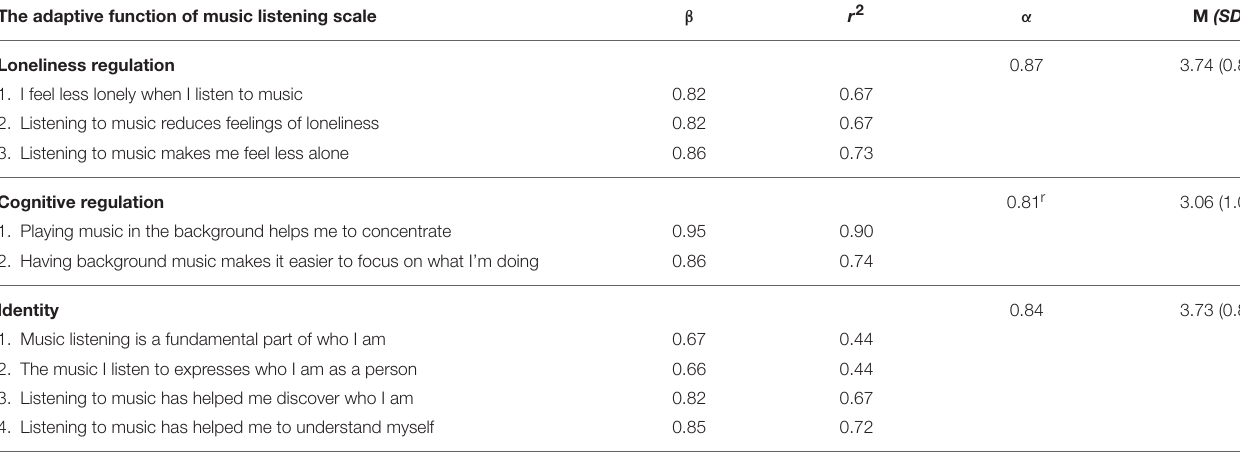
The adaptive function of music listening scale Loneliness regulation